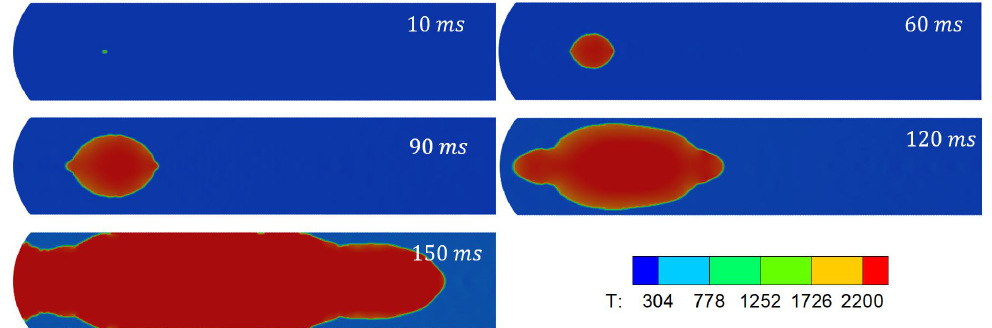
Figure 4. Flame development and propagation after ignition of methane–air mixtures inside the capture duct (5%